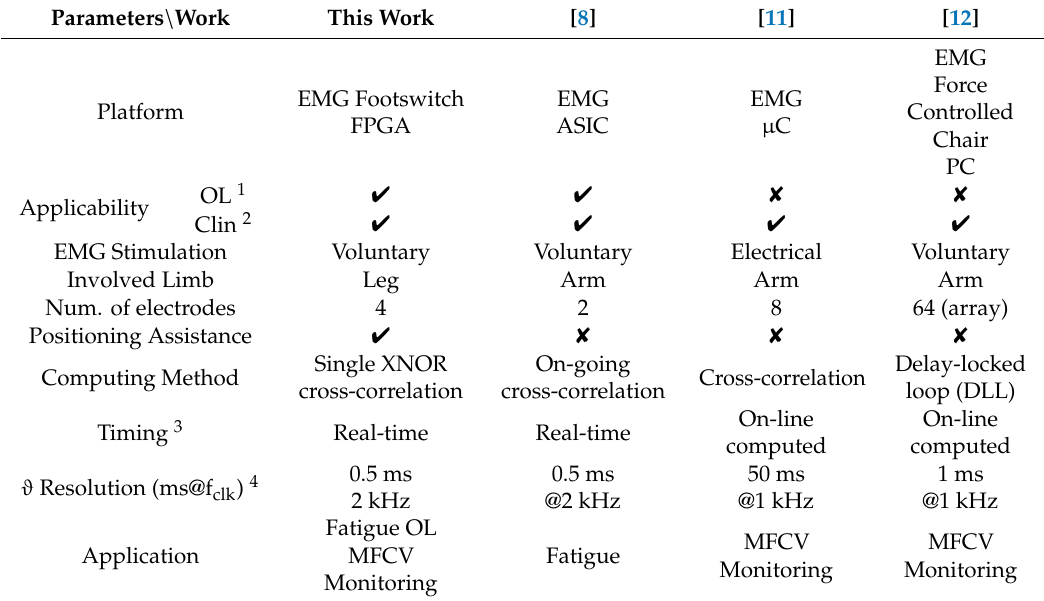
Table 5. State of the field: Comparison